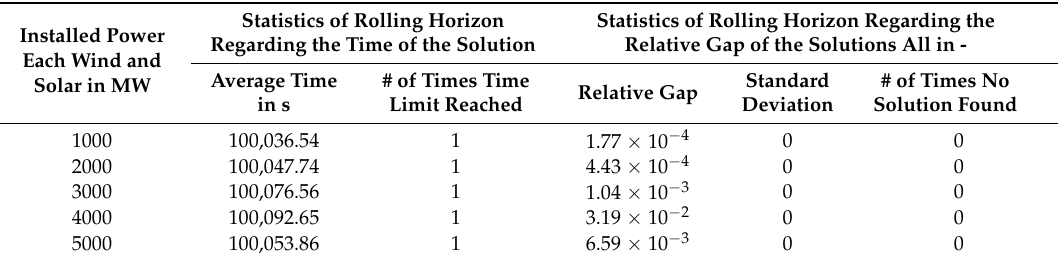
Table A10. Statistics for 365 days optimisation of MILP